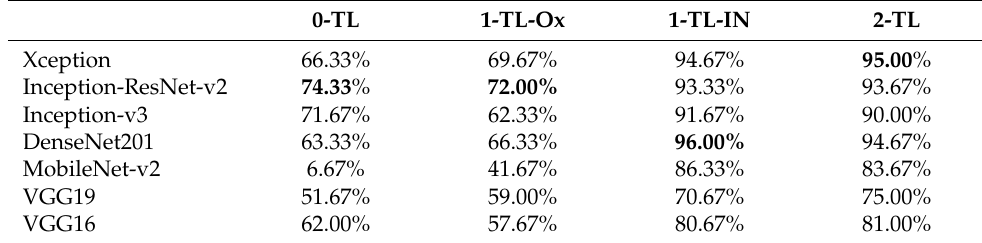
Table 3. The accuracy rates on the Urban Planter dataset in different experiments.